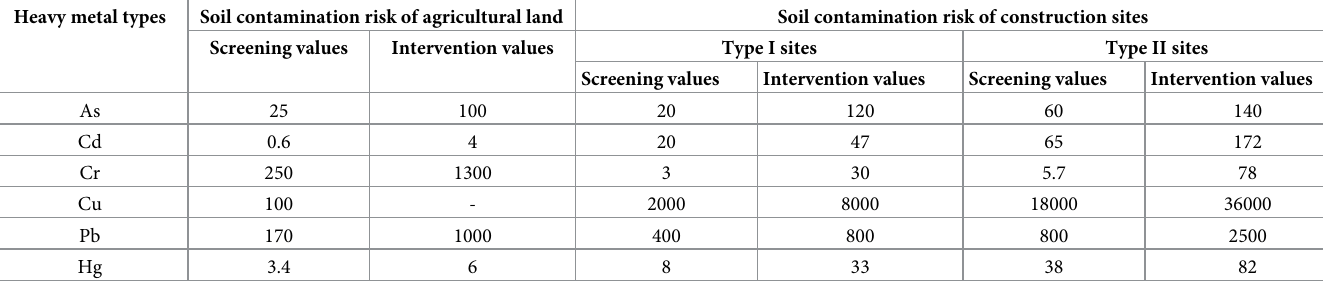
Table 1. Evaluation criteria for excessive heavy metal contamination of soil in the study area. Heavy metal types